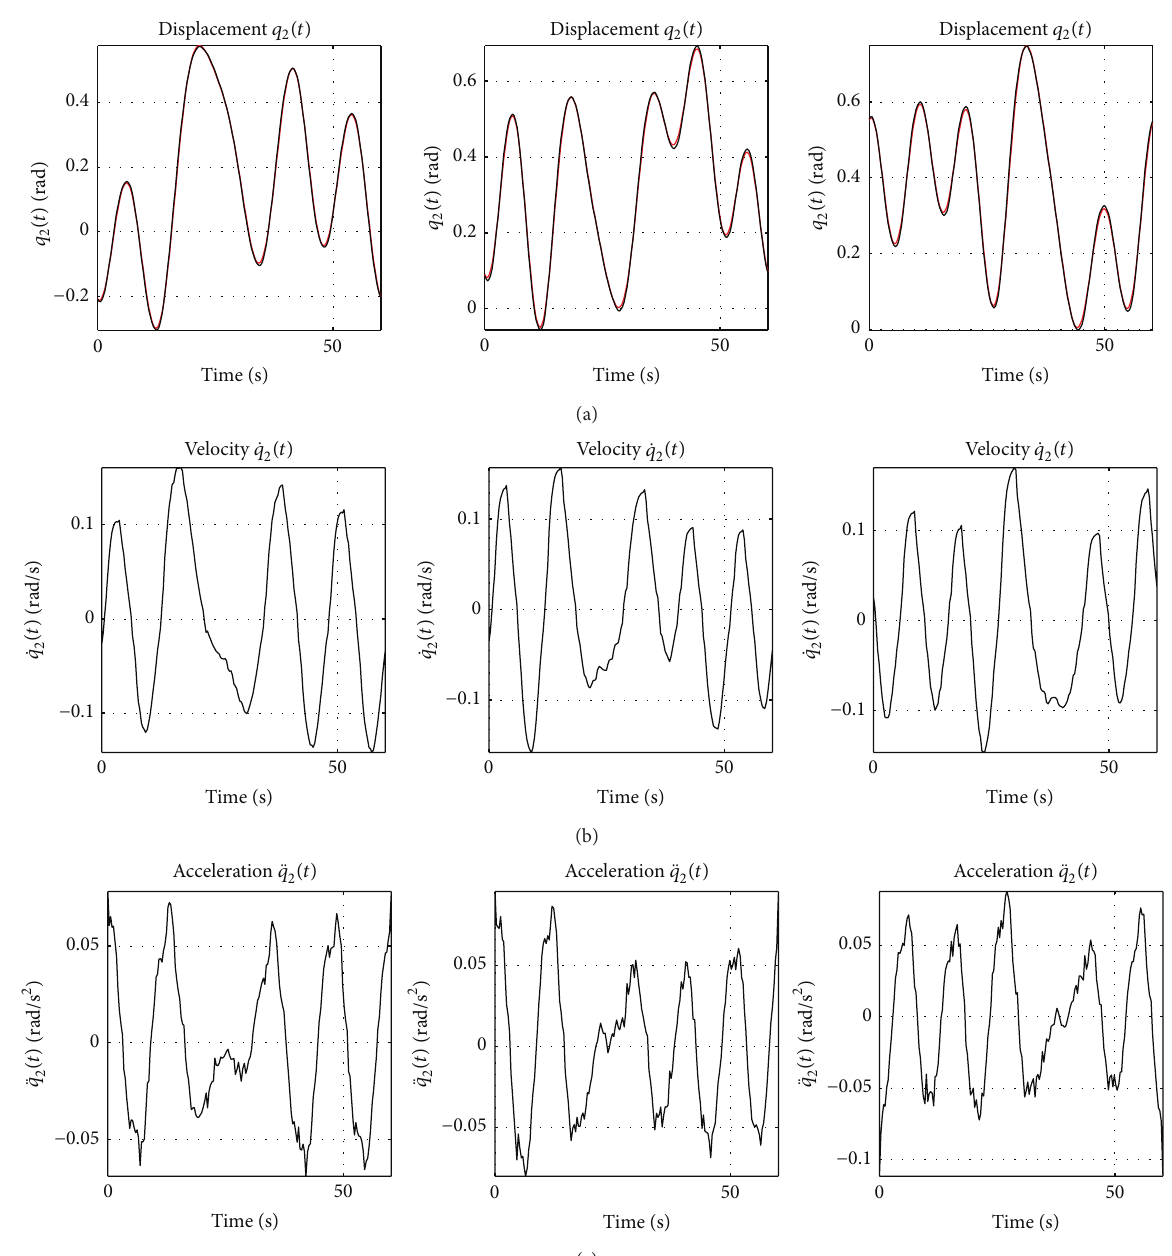
Figure 6: Example of recorded trajectories which resemble finite Fourier series. Each column represents a different data set, which results from an average of many periods. (a) Measured angular position 𝑞 2 (𝑡) in (rad). (b) Estimated angular velocity ̇𝑞 2 (𝑡) in (rad/sec). (c) Estimated angular acceleration ̈𝑞 2 (𝑡) in (rad/sec 2